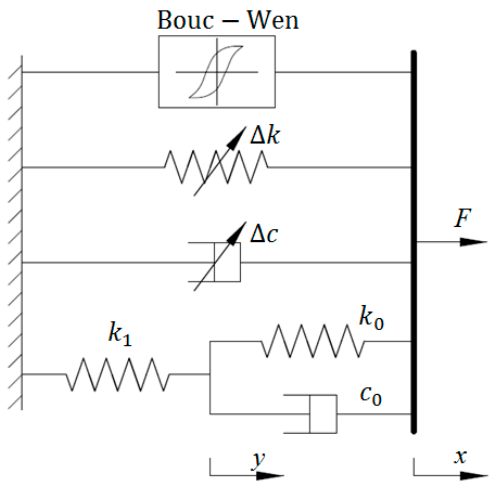
Figure 5. Improved BW model.